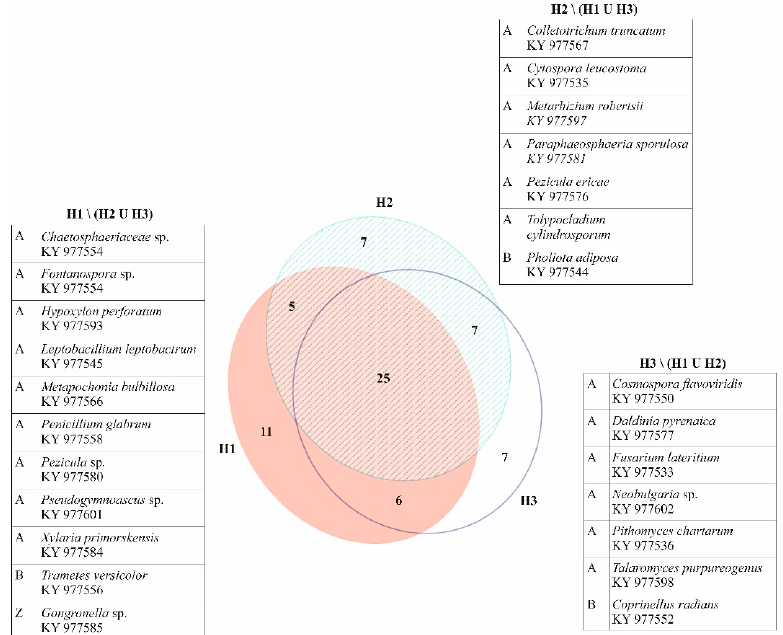
Figure 3. Venn diagram showing numbers of common and unique fungal taxa among di ff erent health categories with list of fungal taxa (and their GenBank sequence accession numbers) present on Fraxinus angustifolia trees in only one health category, mainly found on one tree, and represented by one isolate, with the exception of Neobulgaria sp. (two isolates on one tree), Pholiota adiposa (two isolates on two trees), and Tolypocladium cylindrosporum (five isolates on two trees). A = Ascomycota; B = Basidiomycota; Z =